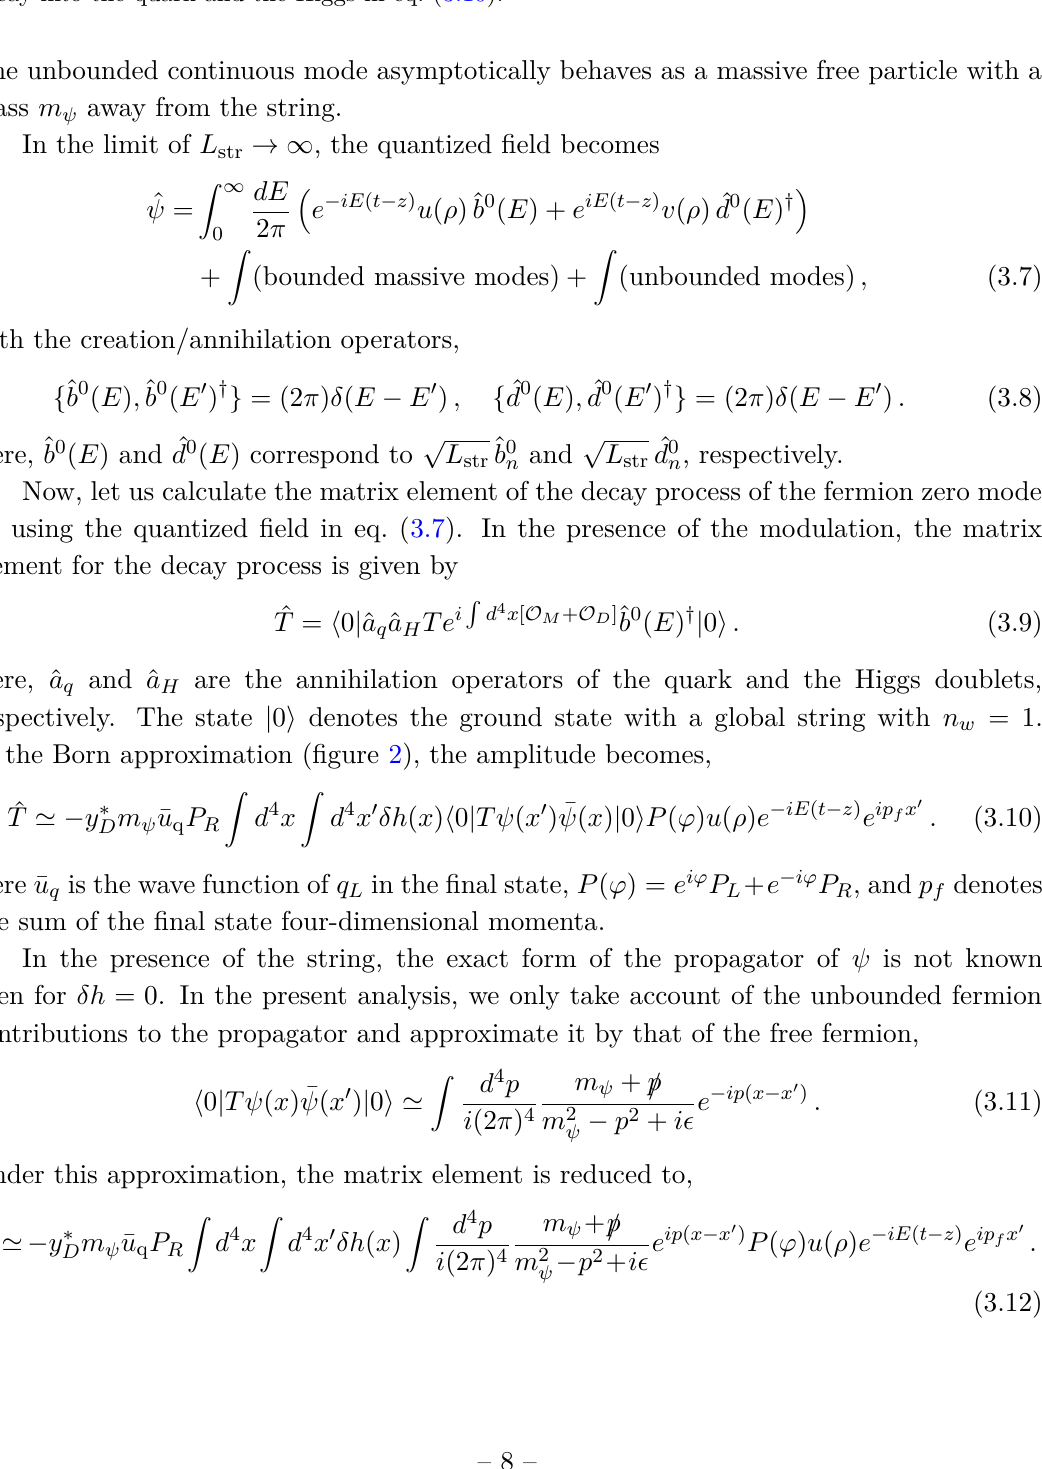
Figure 2 . The Feynman diagram corresponding to the leading order contribution to the zero mode decay into the quark and the Higgs in eq.